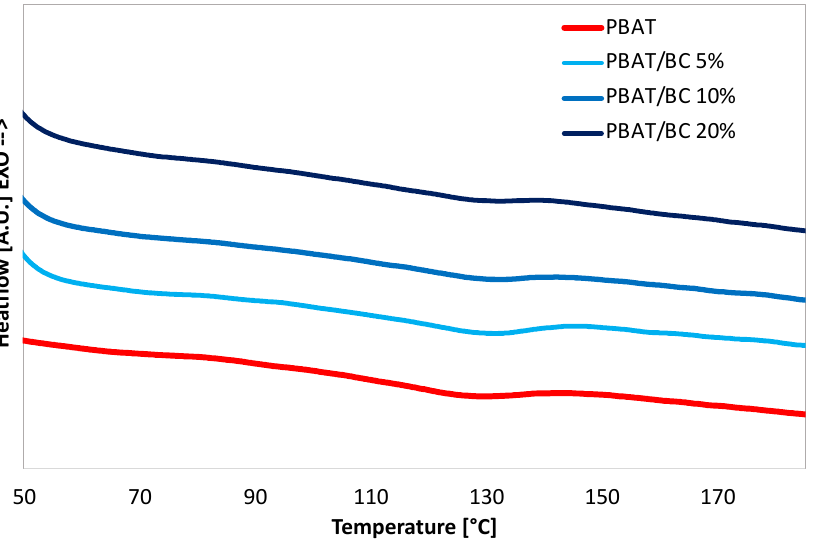
Figure 6. Differential scanning calorimetry (DSC) thermograms recorded during the second heating scan. Table 1. Thermal properties collected during the second heating scan for all investigated systems.